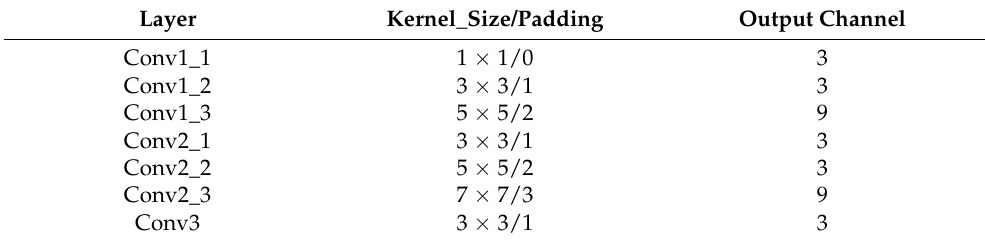
Table 1. Parameter of the convolution layer.